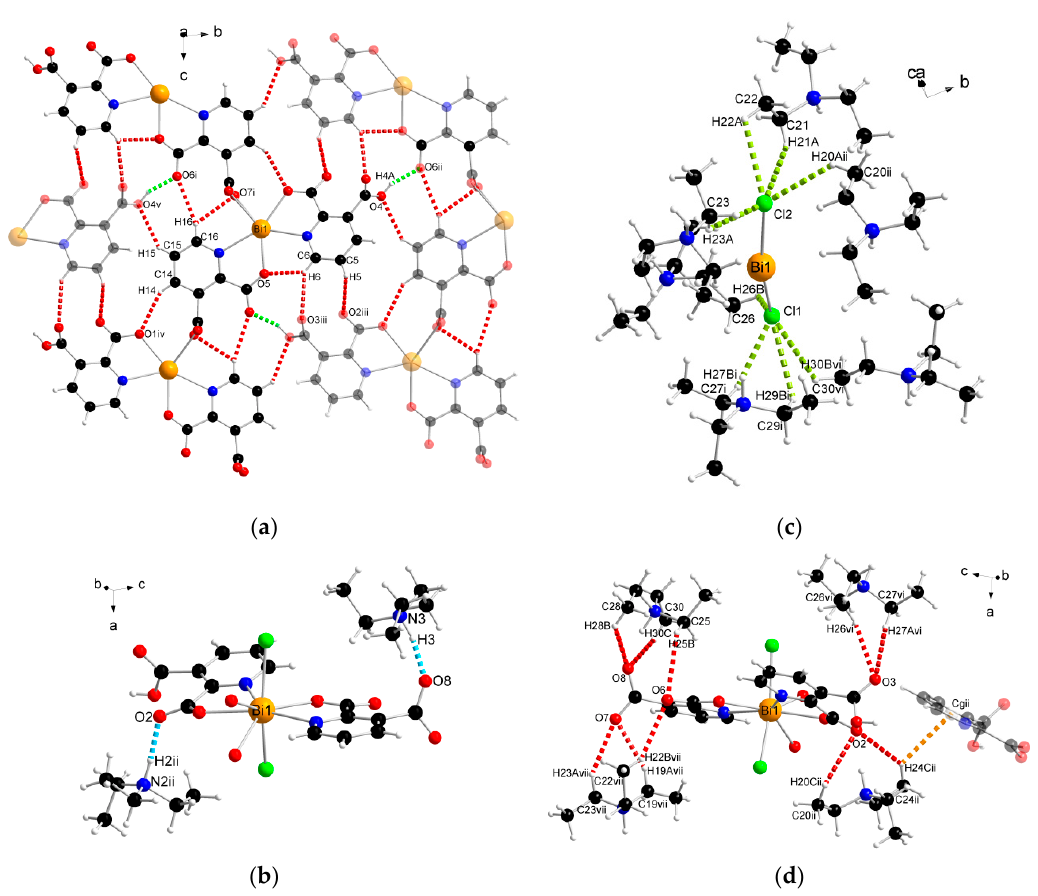
Figure 6. The geometry of noncovalent interactions in complex 2 : ( a ) O/C–H ∙∙∙ O formed between adjacent polymeric chains, ( b ) N–H ∙∙∙ O, ( c ) C–H ∙∙∙ Cl and ( d ) C–H ∙∙∙ O/ π formed between Et 3 NH cations and polymeric chains (translucent molecules belong to adjacent chains) (Bi—orange, O—red, N—blue, Cl—green, C—black, H—white). Table 4. The geometry of noncovalent interactions in complex 2 .